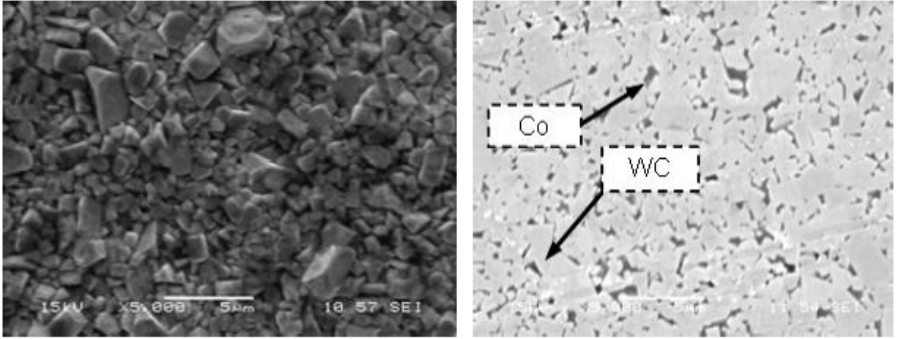
Figure 2. SEM micrograph of cemented carbide tool (WC-6% Co).